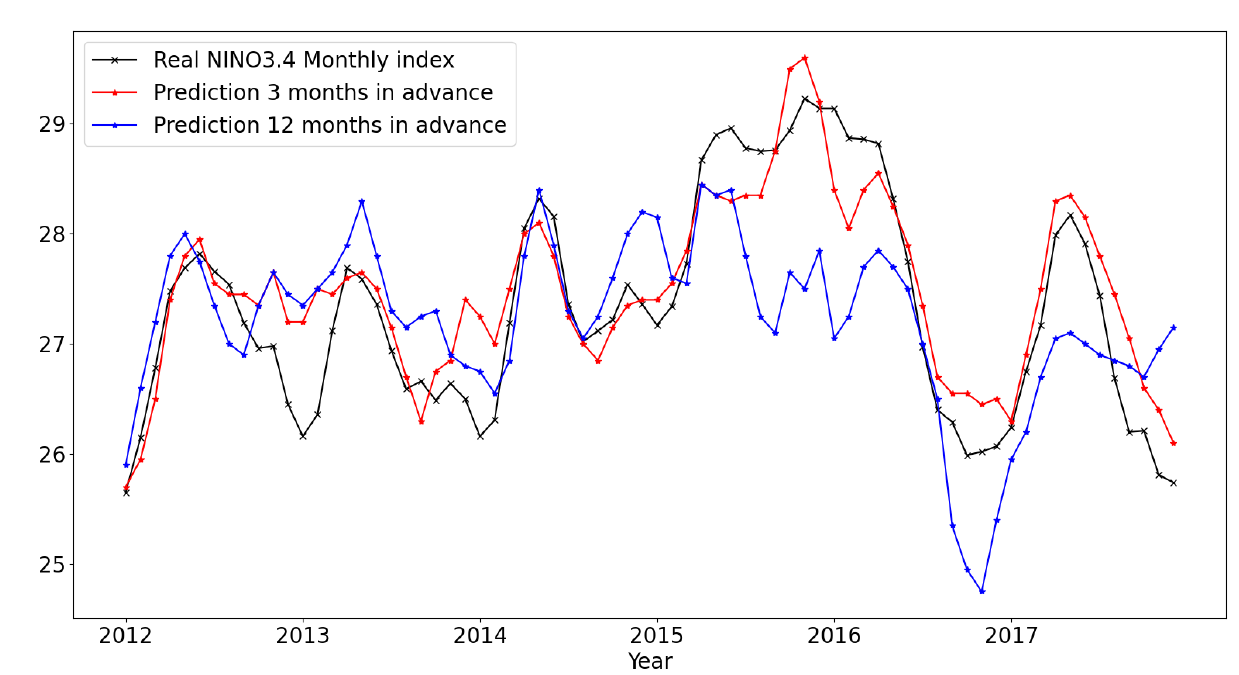
Figure 4. Monthly NINO3.4 predictions (January 2012 to December 2017) using SVD based dimensionality reduction compared with the original NINO3.4 index (black curve). x-axis is months starting from January, 2012.